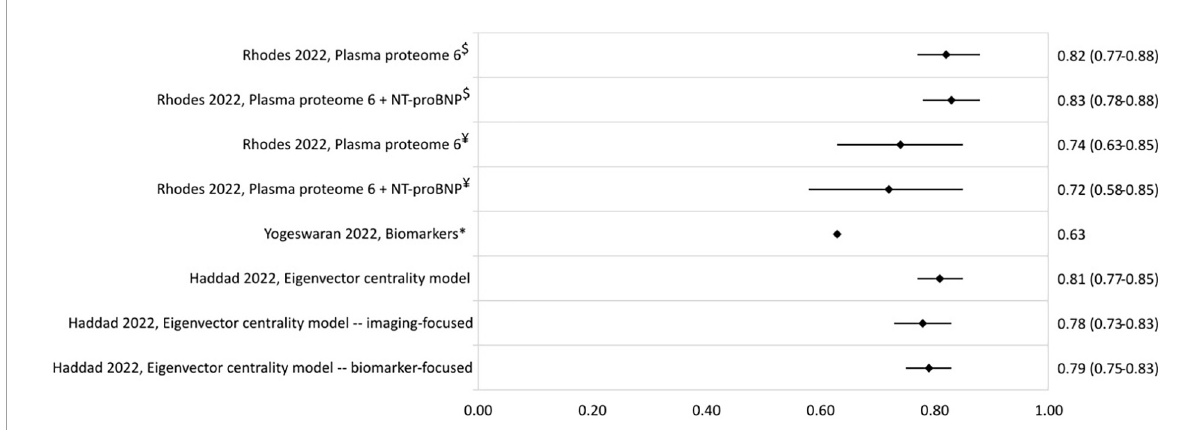
FIGURE5 C-statistic (95% CI) of biomarker and eigenvector centrality risk stratification models. NT-proBNP, N-terminal-pro brain natriuretic peptide. $ Derivation cohort, (cid:85) validation cohort, ∗ cohort includes PAH and chronic thromboembolic PH